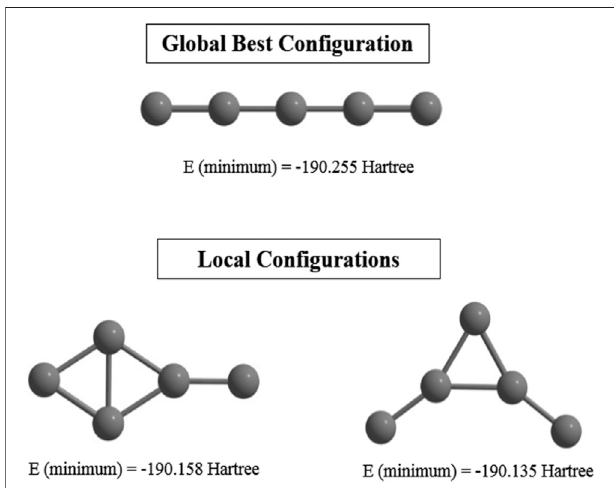
FIGURE 3 | Global and local minimum energy structures of C 5 cluster obtained at the end of the post-processing step computed at the B3LYP/6- 311+G(d,p) level. (Reprinted from Mitra et al., 2021 with permission from Theoretical Chemistry Accounts, Springer Nature. Copyright© 2021, Springer-Verlag GmbH,